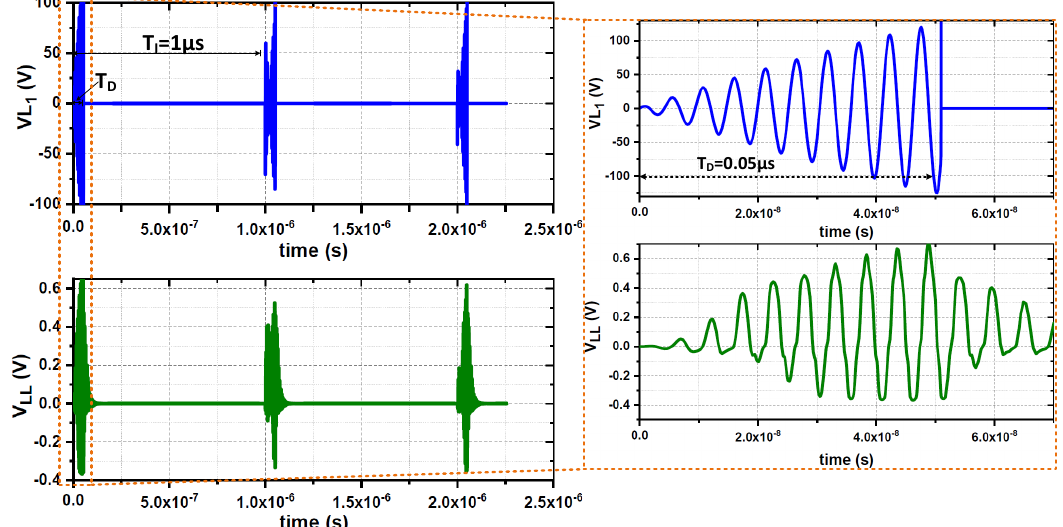
Figure 9. Simulated V L 1 and V LL waveforms at T I = 1 µ s and D = 5%.